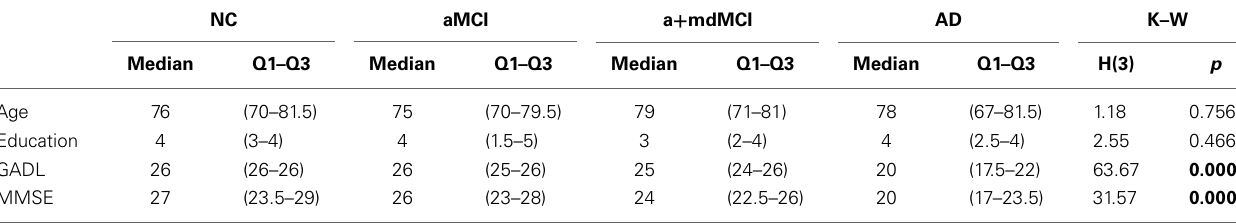
Table 3 | Demographic description of NC, aMCI, a-mdMCI, and AD groups.